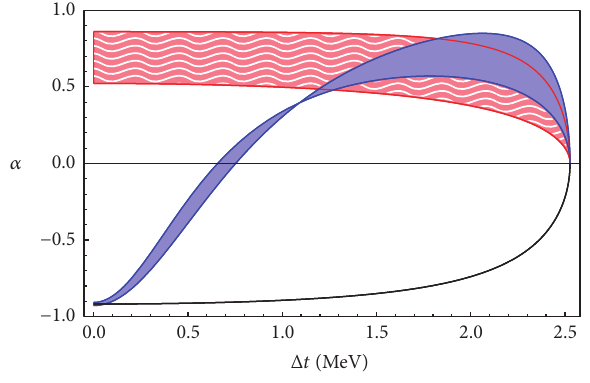
Figure 9: Same as Figure 8 for 130 Te.